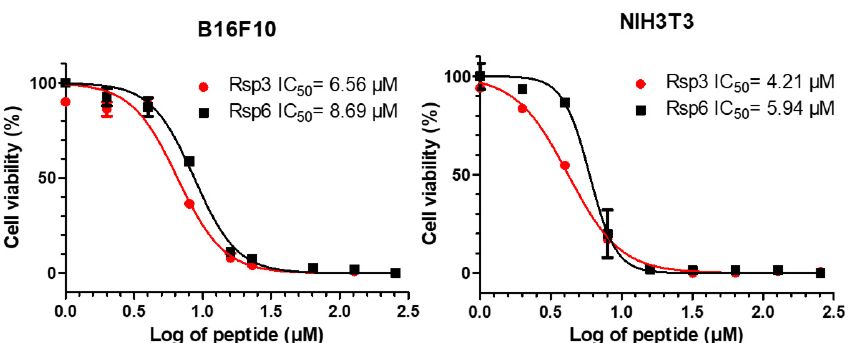
Figure 9. The antiproliferative effects of Raniseptins-3 and -6 on murine skin melanoma B16F10 cells and NIH3T3 mouse fibroblasts cells.